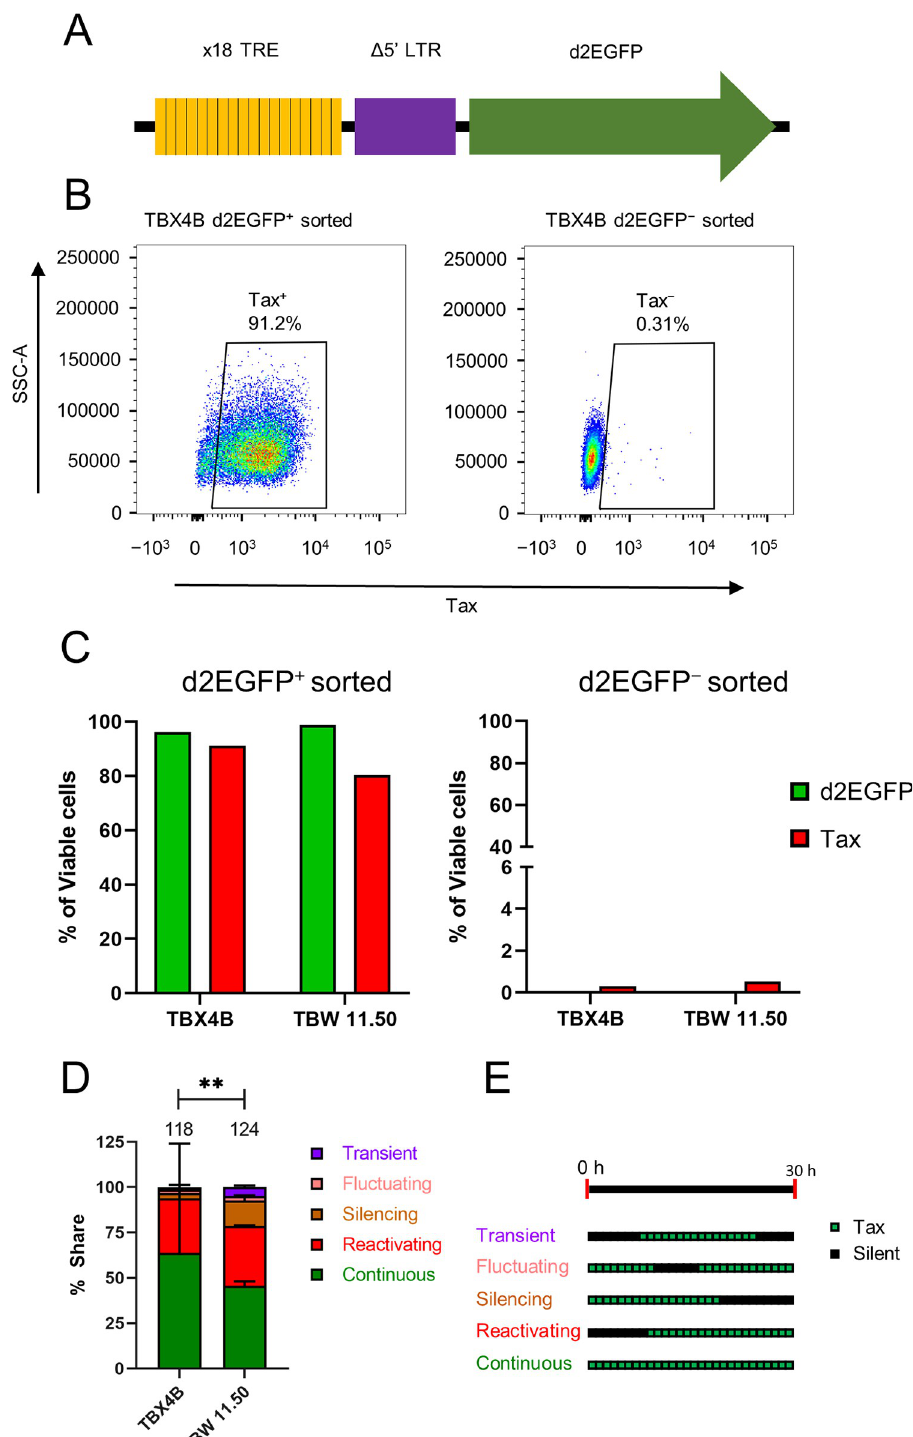
Fig 1. Live-cell imaging reveals multiple patterns of Tax expression in naturally-infected T-cell clones. (A) Tax- reporter construct, containing 18 copies of the Tax-responsive element and a truncated HTLV-1 LTR upstream of the d2EGFP gene. (B) Representative flow cytometric plots from clone d2EGFP TBX4B depicting Tax protein expression in FACS-sorted d2EGFP + and d2EGFP - cells. (C) d2EGFP and Tax protein expression among FACS-sorted d2EGFP + and d2EGFP - cells from clones d2EGFP TBX4B and d2EGFP TBW 11.50 from a single experiment. (D) Time-lapse